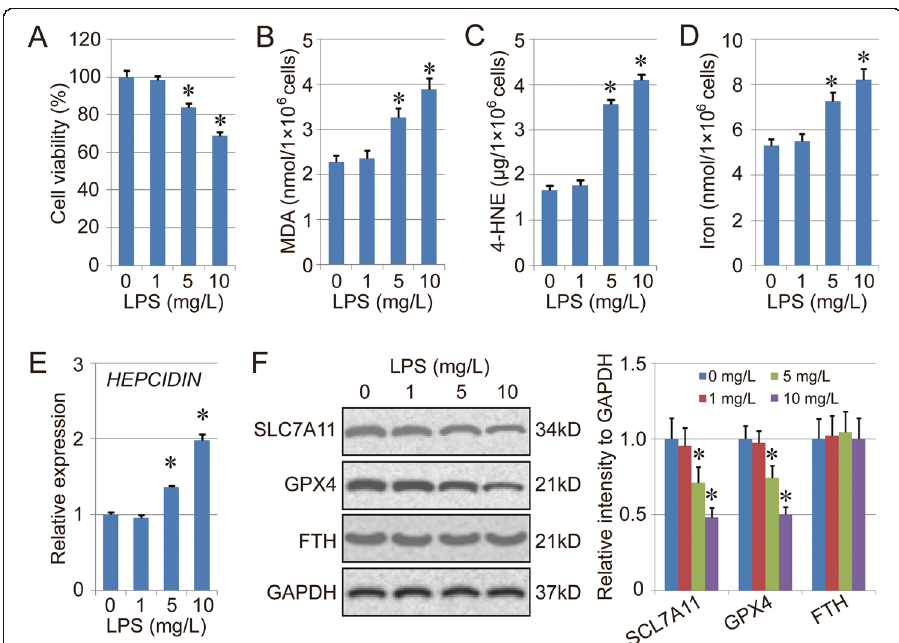
Fig. 1 The effect of LPS treatment on ferroptosis in BEAS-2B cells. a . Cell viability of BEAS-2B cells treated with LPS. The cells were treated with LPS in different concentrations (1, 5, and 10 mg/L) for 16 h, then the cell viability of each group was measured using CCK-8. b - d . Levels of MDA (B), 4-HNE (C) and total iron (D) in the BESA-2B cells treated with LPS. e . mRNA expression of HEPCIDIN . f . Protein levels of SLC7A11 and GPX4 in the BESA-2B cells treated with LPS. Results are expressed as means±SEM ( n = 3). *: p < 0.05 compared with the 0 mg/L